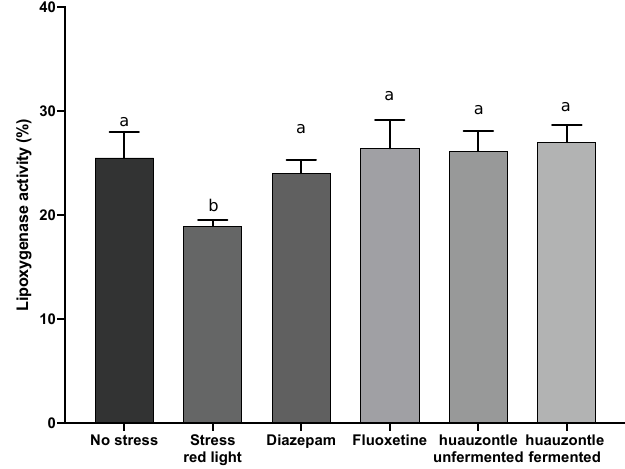
Figure 4. Lipoxygenase activity in samples of hippocampus. Different letters showed statistical difference among groups. Date shown the percentage ± DS, (n = 5), p < 0.05.